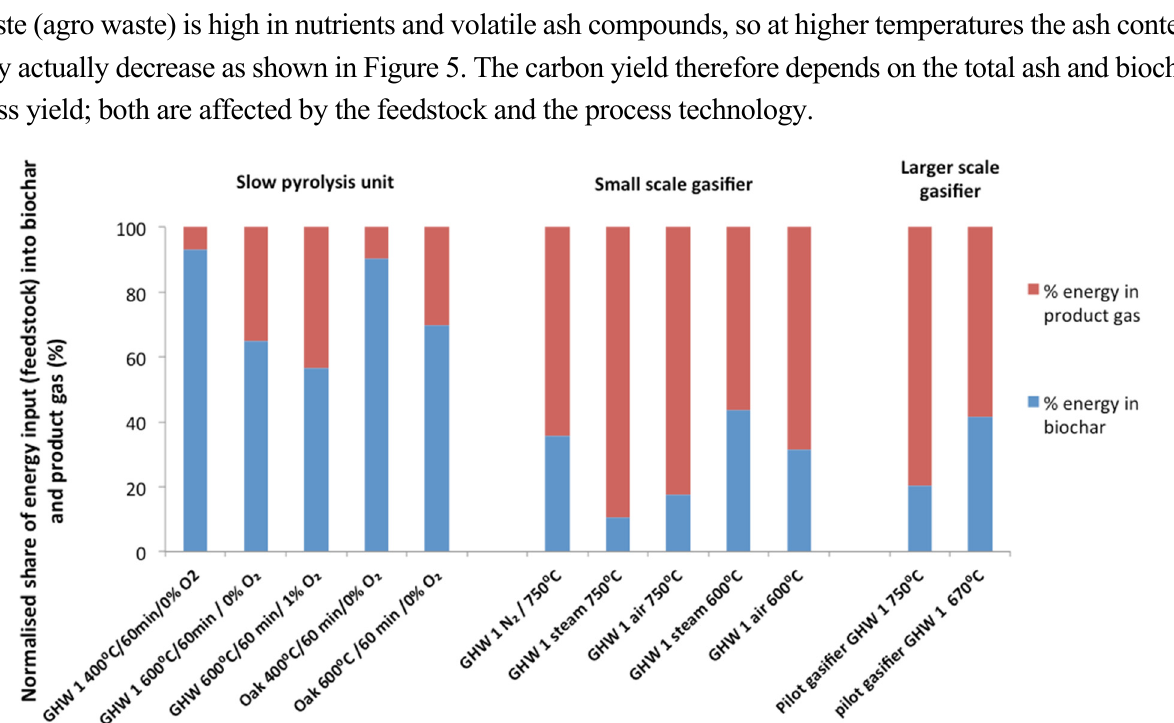
Figure 5. Normalized energy distribution of the input feedstock into biochar and product